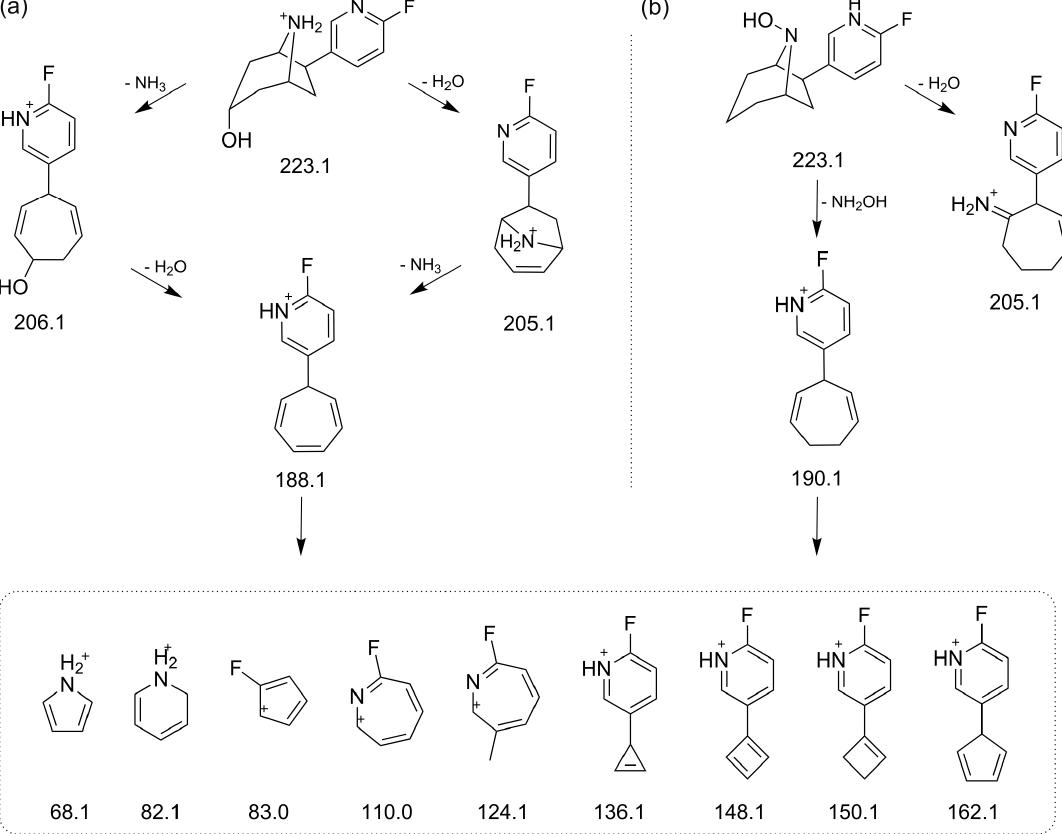
Figure 6. Proposed basic fragmentation pathways and structures for observed major fragment ions of metabolites detected during enhanced product ion (EPI) scans: ( a ) for M0 to M4 (illustrated for M1); and ( b ) for M5 (occurrence and intensity of fragments vary depending on the respective metabolite, and regiochemical, stereochemical and mesomeric issues have been neglected).